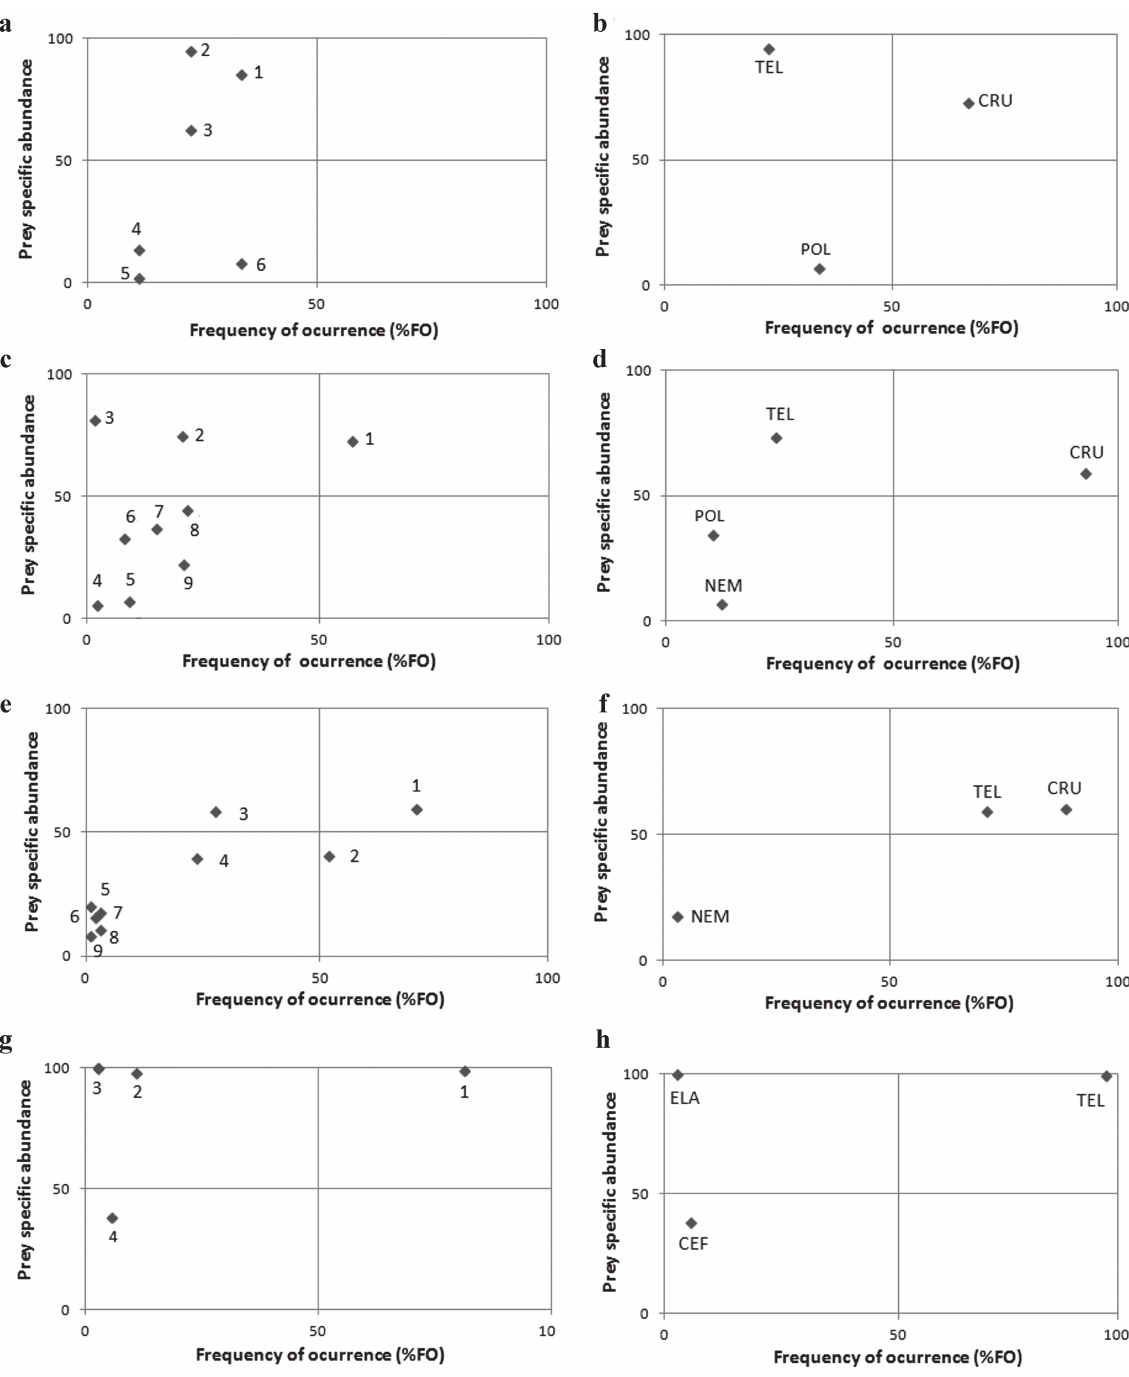
Fig. 3. Diet of species analyzed by Costello’s method (1990) as adapted by Amundsen et al . (1996), in the southeastern Brazil, between January 2006 and August 2007, by food items and by groups. ( a / b ) Psammobatis rutrum : a . Food items: 1) Shrimp (not identified), 2) Teleost fragments, 3) Crustacean fragments, 4) Amphipoda, 5) Brachyura 6) Polychaeta. b . Groups: Crustacea (CRU), Teleosts (TEL) and Polychaeta (POL). ( c / d ) Psammobatis extenta : c . Food items: 1) Shrimp (not identified), 2) Teleost fragments, 3) Isopoda, 4) Stomatopoda, 5) Nematoda, 6) Polychaeta, 7) Brachyura, 8) Crustacean fragments, 9) Amphipoda. d . Groups: Crustacea (CRU), Teleosts (TEL), Polychaeta (POL), Nematoda (NEM). ( e / f ) Rioraja agassizii : e . Food items: 1) Teleost fragments, 2) Shrimp (not identified), 3) Brachyura, 4) Crustacean Fragments, 5) Thalassinidae, 6) Nematoda, 7) Stomatopoda, 8) Amphipoda, 9) Lophogastrida. f . Groups: Crustacea (CRU), Teleosts (TEL), Nematoda (NEM). (g/h) Rhizoprionodon lalandii : g . Food items: 1) Teleost fragments, 2) Dactylopterus volitans , 3) Triglidae, Merluccius hubbsi and elasmobranchs, 4) Loligo plei . h . Groups: Teleosts (TEL), Elasmobranchs (ELA), Cephalopoda